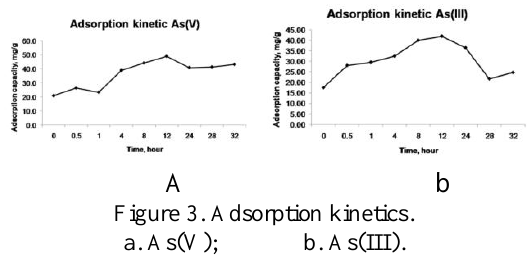
Figure 3. Adsorption kinetics. a. As(V); b. As(III).